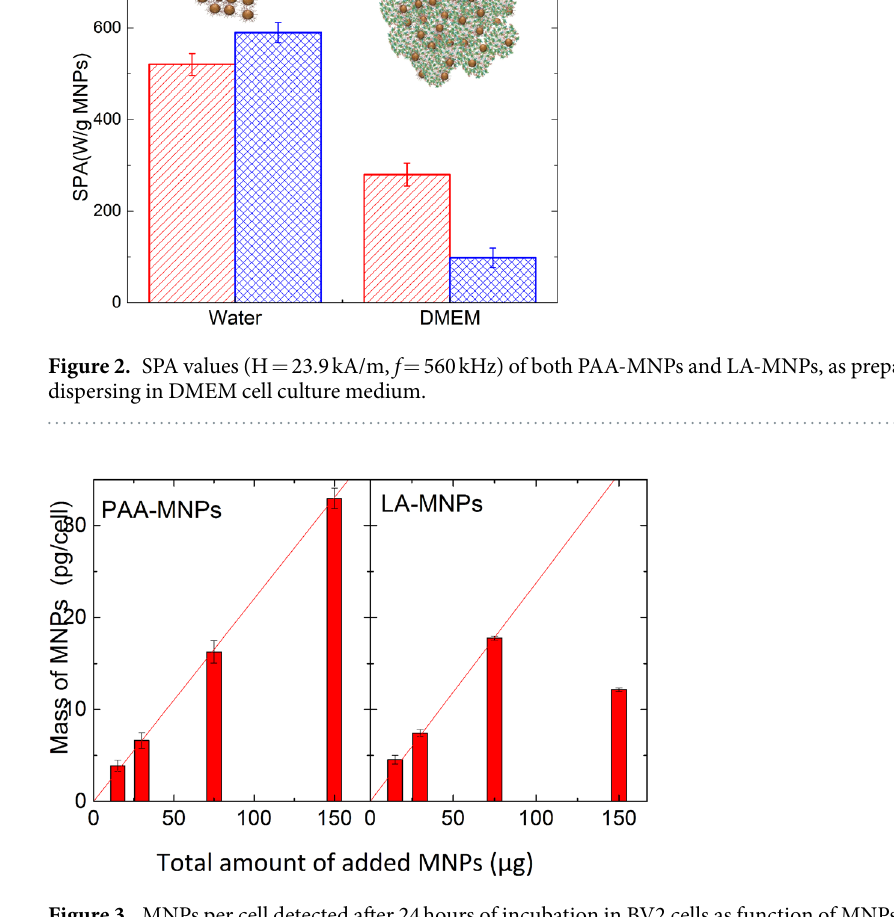
Figure 3. MNPs per cell detected after 24 hours of incubation in BV2 cells as function of MNPs